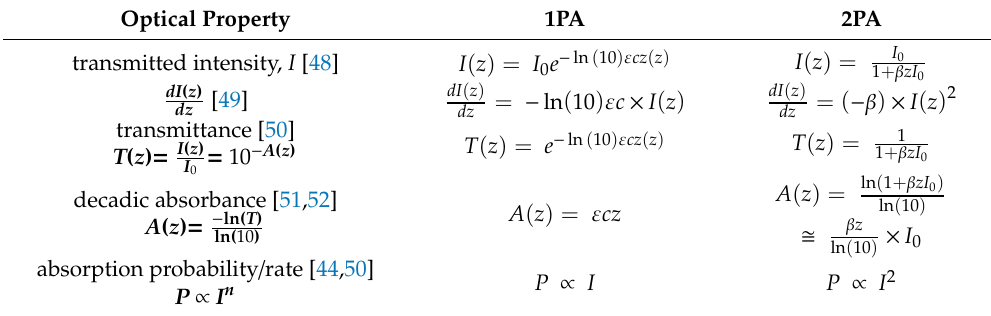
Table 1. Comparison of optical properties for single photon absorption (1PA) versus two-photon absorption